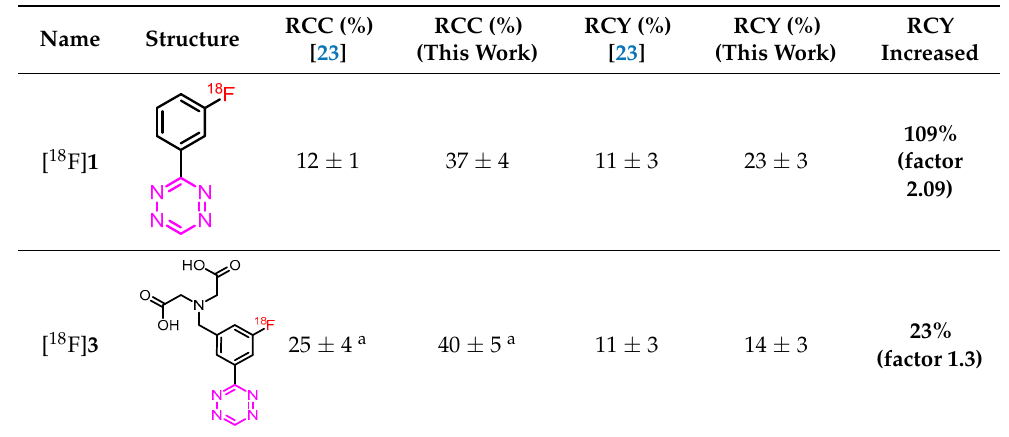
Table 2. Results of the Cu-mediated 18 F-fluorination optimization for H-Tzs [ 18 F] 1 and [ 18 F] 3 .